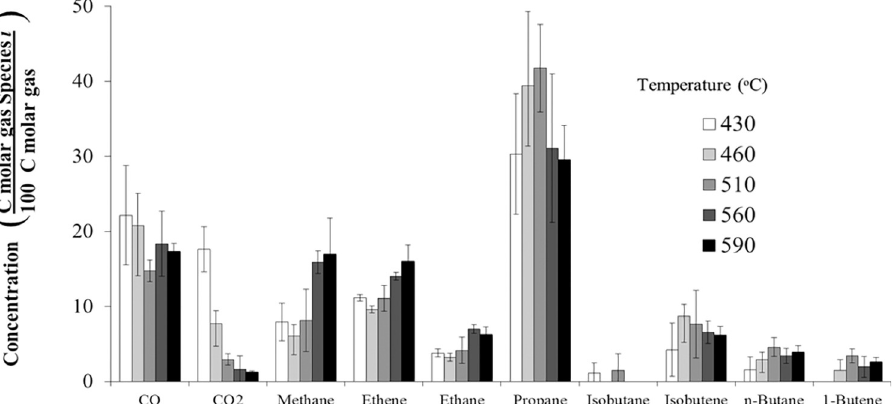
Fig 16. Gaseous product distribution of mixed-ketone reaction over HZSM-5(280), WHSV = 1.9 h –1 , and P = 101 kPa (abs).